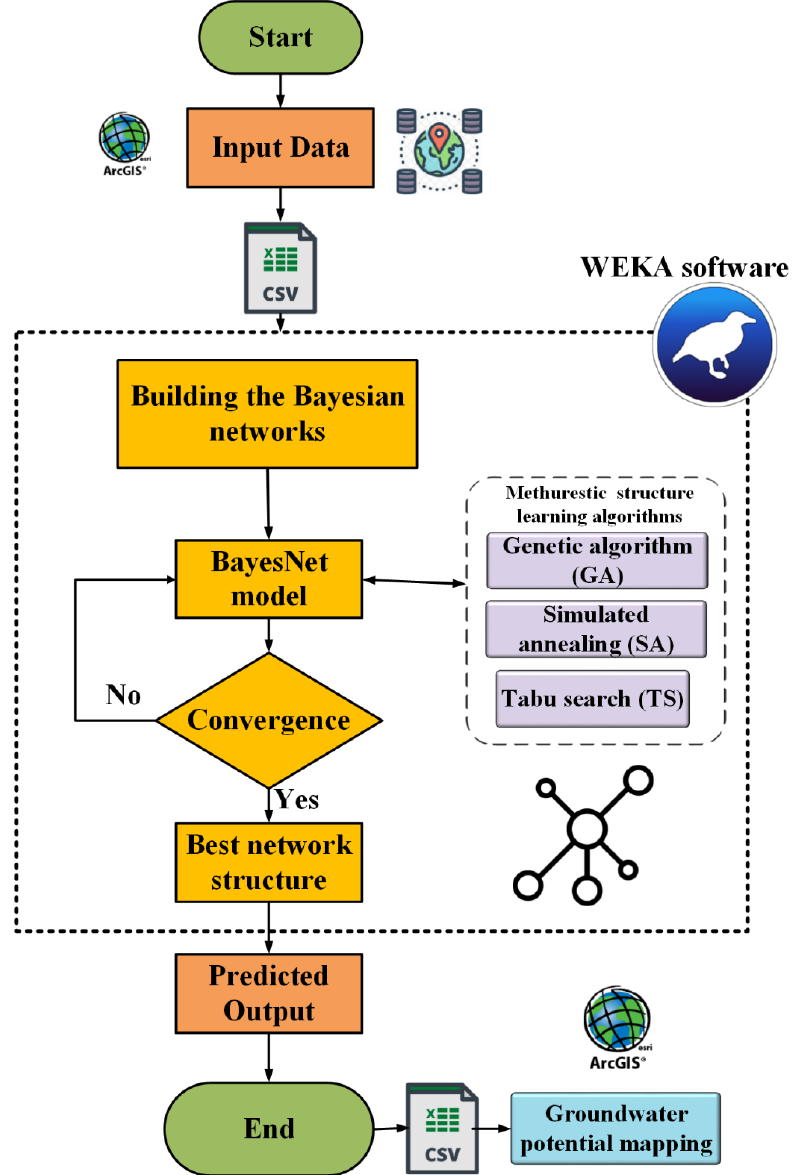
Figure 4. Flowchart of the hybrid model.